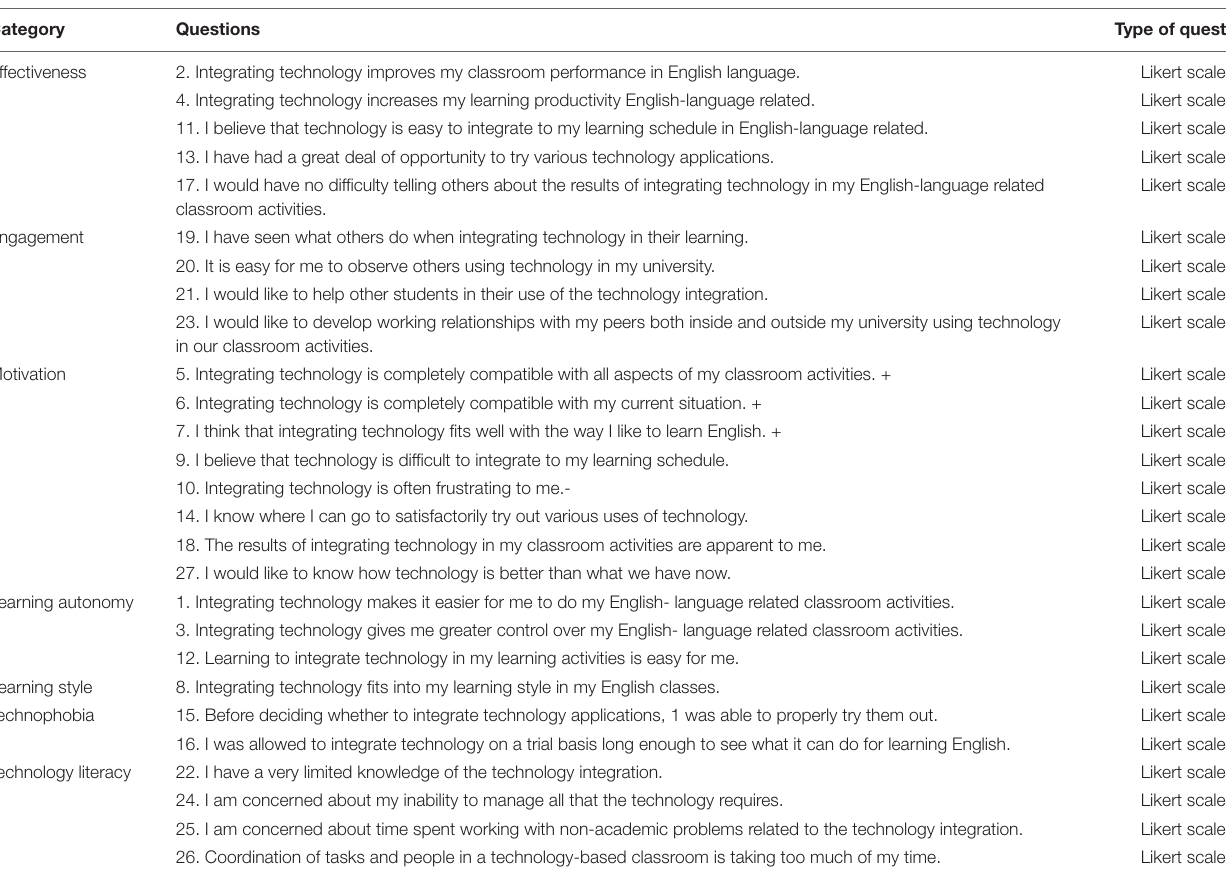
TABLE 1 | The categories of the questionnaire and the questions under every